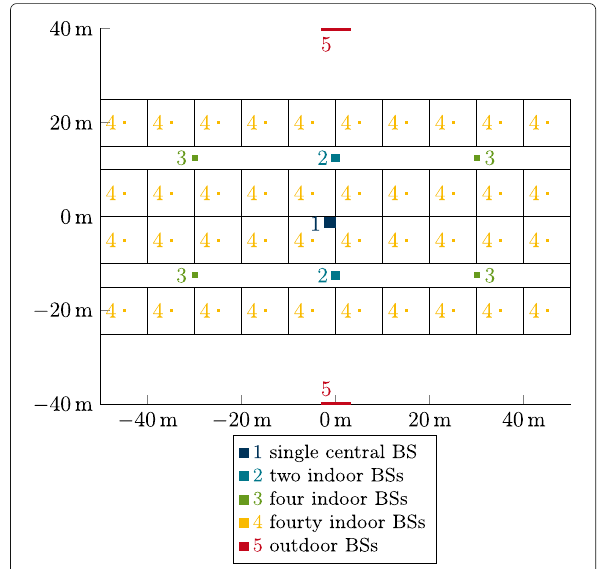
Fig. 1 Deployments. Base station deployments in the indoor office scenario [20]